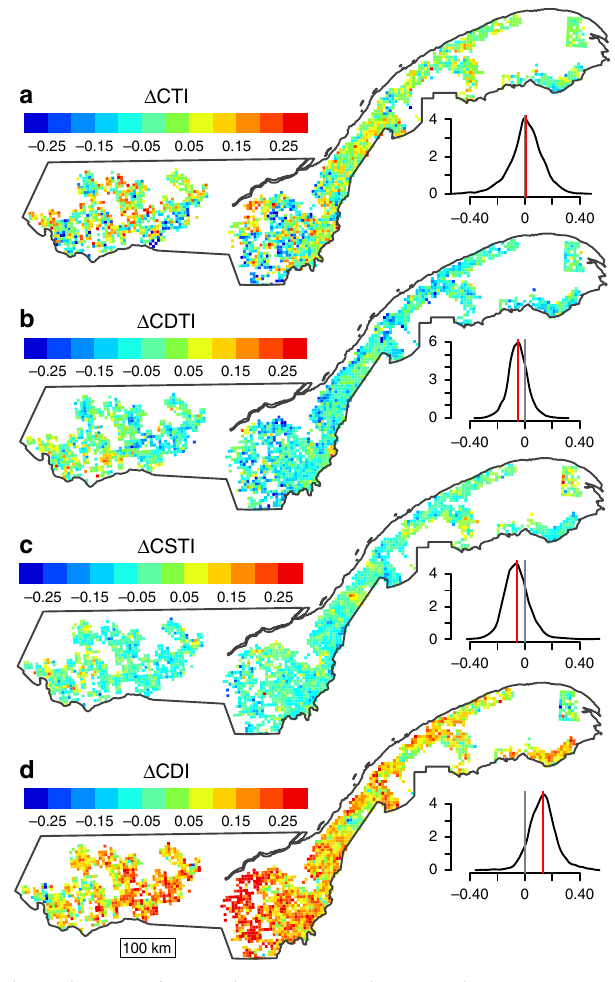
Fig. 2 Changes in functional composition. Changes in the community temperature index ( Δ CTI; a ), the community drought tolerance index ( Δ CDTI; b ), the community shade tolerance index ( Δ CSTI; c ) and the community disturbance index ( Δ CDI; d ) between 1790 – 1900 and 1980 – 2010. Smoothed distributions are shown next to each map (vertical gray and red lines show 0 and mean values, respectively). Detailed maps